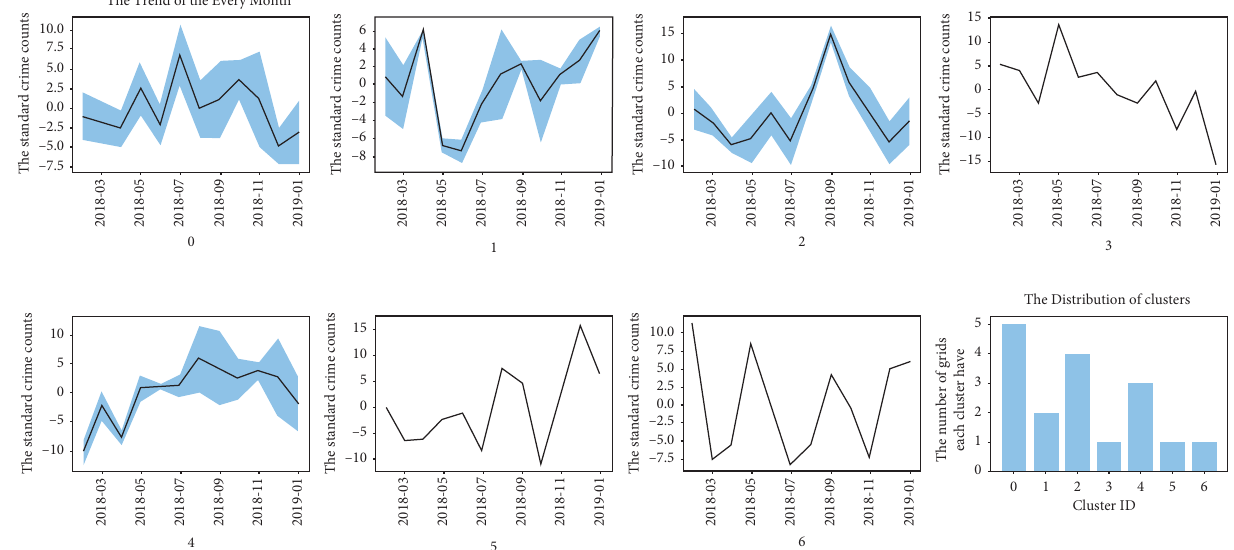
Figure 22: The burglary in New York trends in each month in 2018 and the distribution of clusters. The line charts are the monthly trends of burglary in New York in 2018. The bar chart is the distribution of the clusters. Table 3: Two types in each considered dataset. Data resource